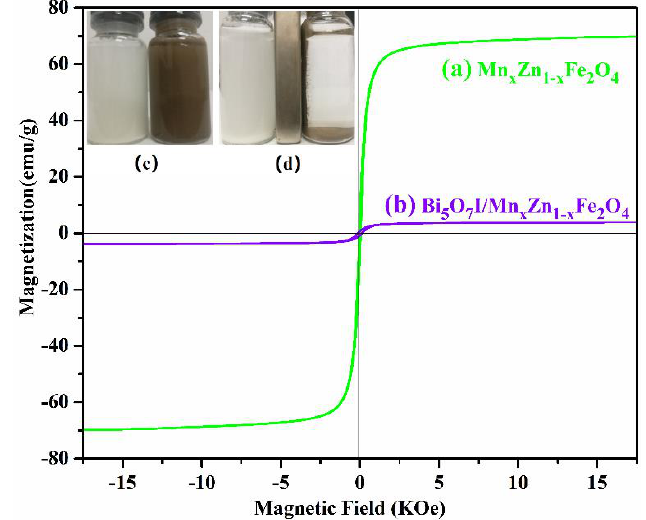
Figure 7. ( a ) Ultraviolet-visible light (UV-Vis) diffuse reflectance spectrum of Bi 5 O 7 I; ( b ) UV-Vis diffuse reflectance spectrum of Bi 5 O 7 I/Mn x Zn 1 − x Fe 2 O 4 . The ( ahv ) 1/2 − hv curve is shown in the inset image.